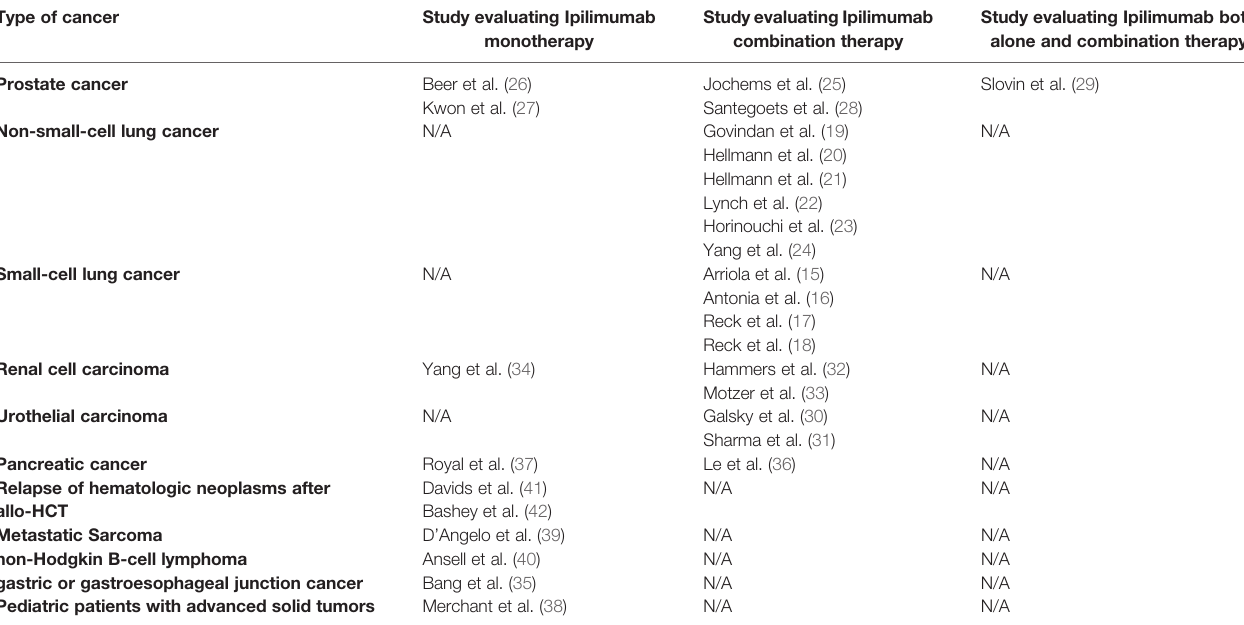
TABLE 1 | Selected studies evaluating ipilimumab in non-melanoma